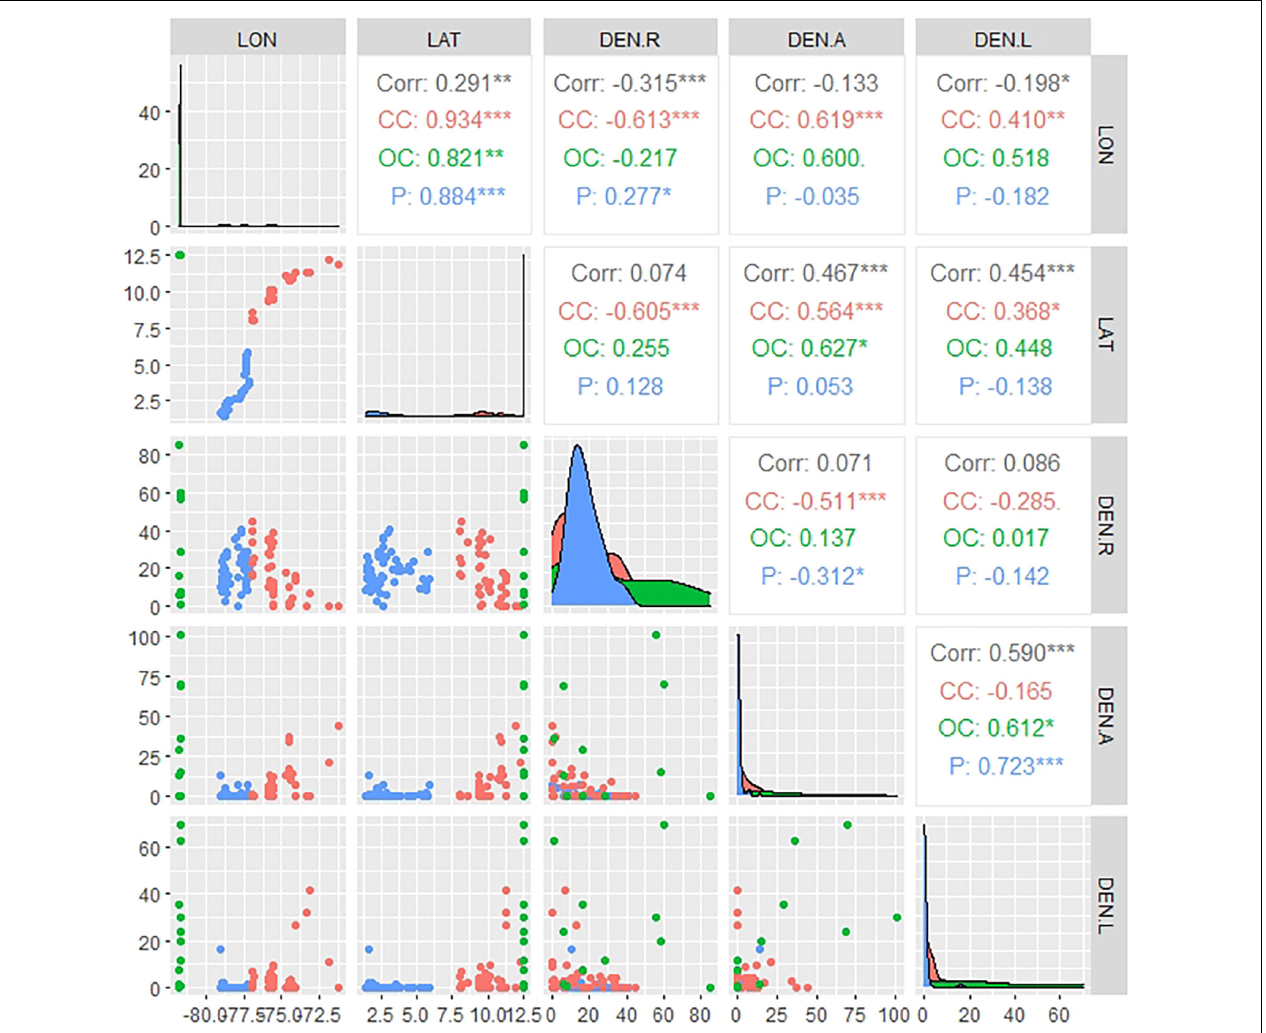
FIGURE 2 | Correlation matrix between the geographical coordinates and density values for the three dominant mangrove species ( Rhizophora species complex, Avicennia germinans , Laguncularia racemosa ) in the continental and oceanic coasts in the Caribbean (CC and OC, respectively) and the continental Pacific coast (P) of Colombia (note color coding). The upper half of the matrix shows the Pearson correlation indices with significance level indicated as asterisks for the total dataset and subsets for CC, OC, and P. The lower half panels show the scatter plots, and the diagonal boxes show the frequency distributions for each coast in different colors. Data available in HELIO_SP.CO v.2. Drawn using ggpairs function in GGally extension for ggplot2 package for